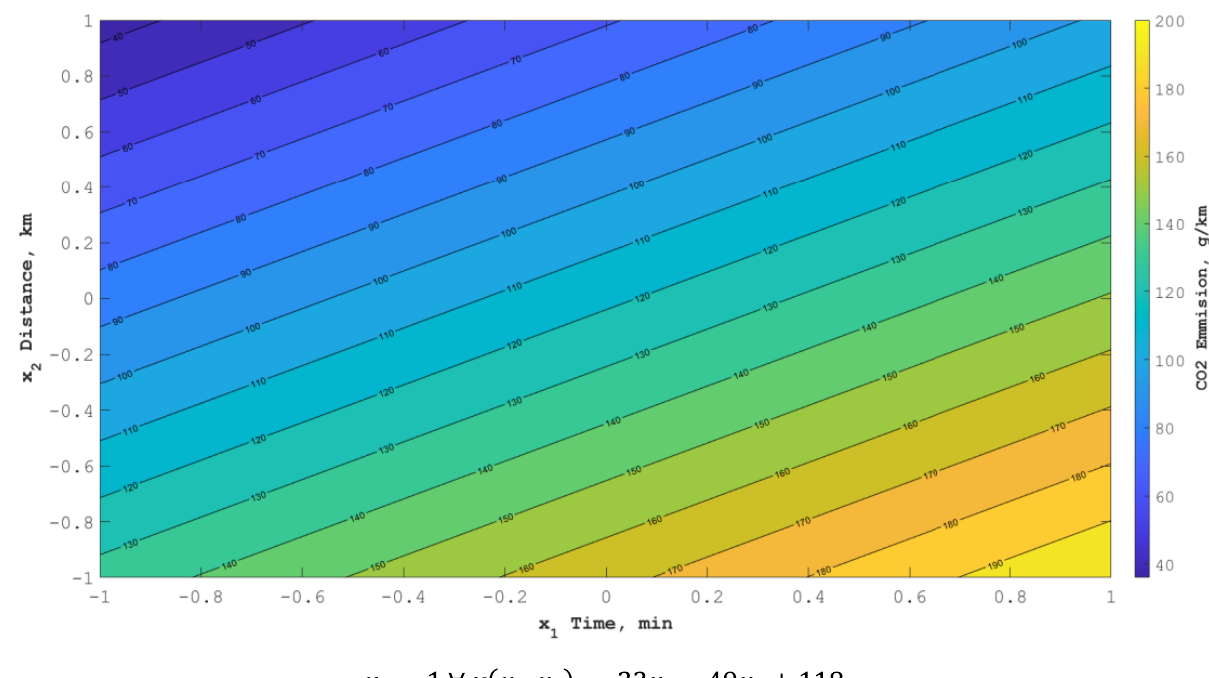
Figure 19. Change in CO 2 emissions depending on the variability of factors x 1 and x 2 for a vehicle (EV) moving at a temperature of 25 °C (x 3 = 1).